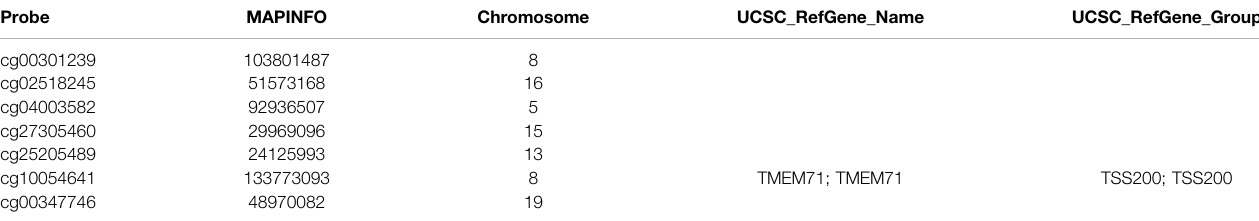
TABLE 2 | Annotation of the seven signature